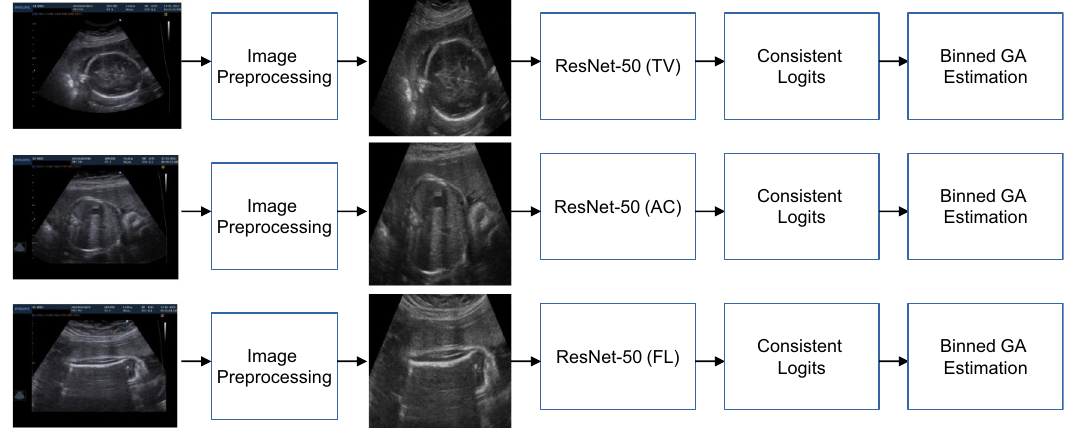
Fig. 5 Training process for single plane estimation of gestational age. Schematic of training process for single ultrasound standard plane- based gestational age (GA) estimation using Consistent Rank Logit Loss. HC Head Circumference; GA Gestational Age; AC Abdominal Circumference; FL Femur